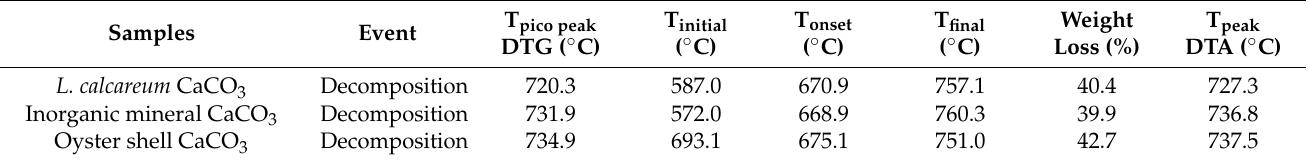
Table 3. Thermo-analytical results for Lithothamnium. calcareum , inorganic mineral, and oyster shell CaCO 3 .